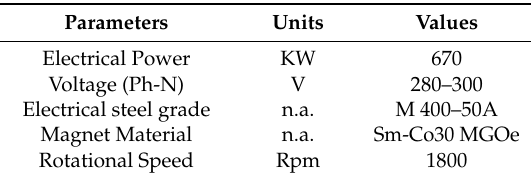
Table 6. Requirements.